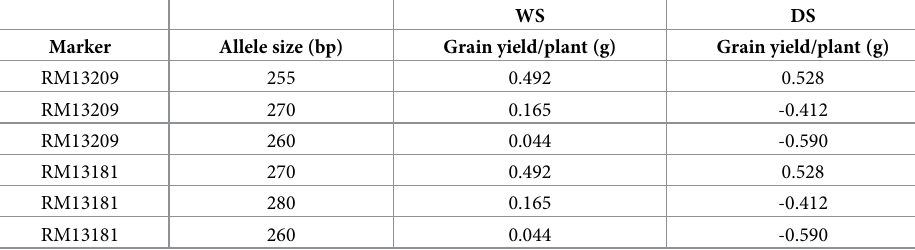
Table 4. Positive average allele effect of RM13209 and RM13181 in 54 genotypes across seasons.